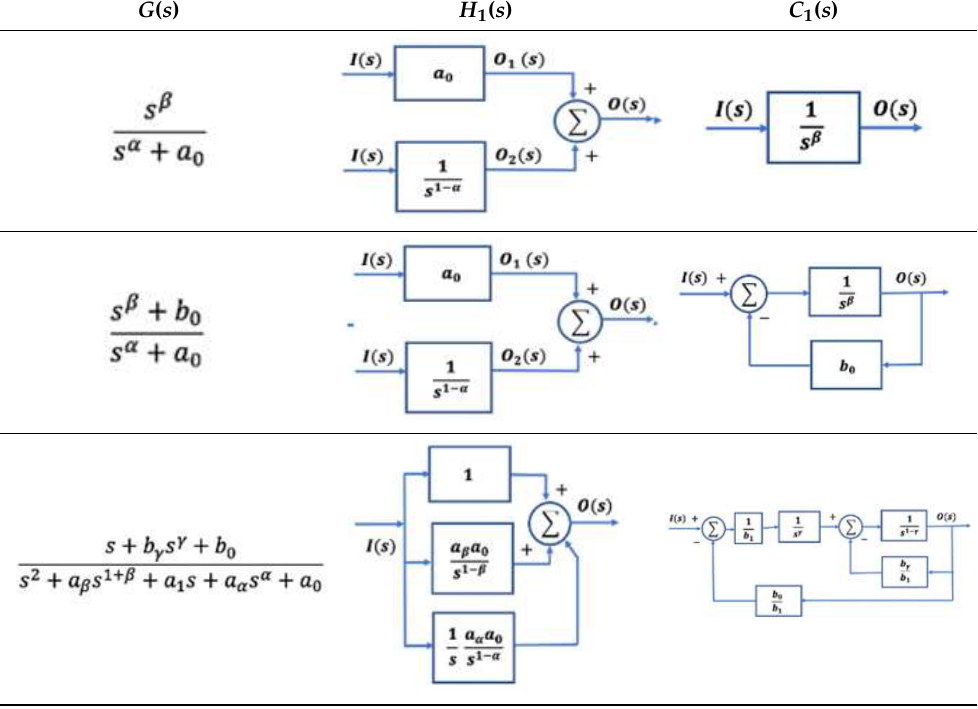
Table 3. Realization of the Outer Loop Compensation Terms.